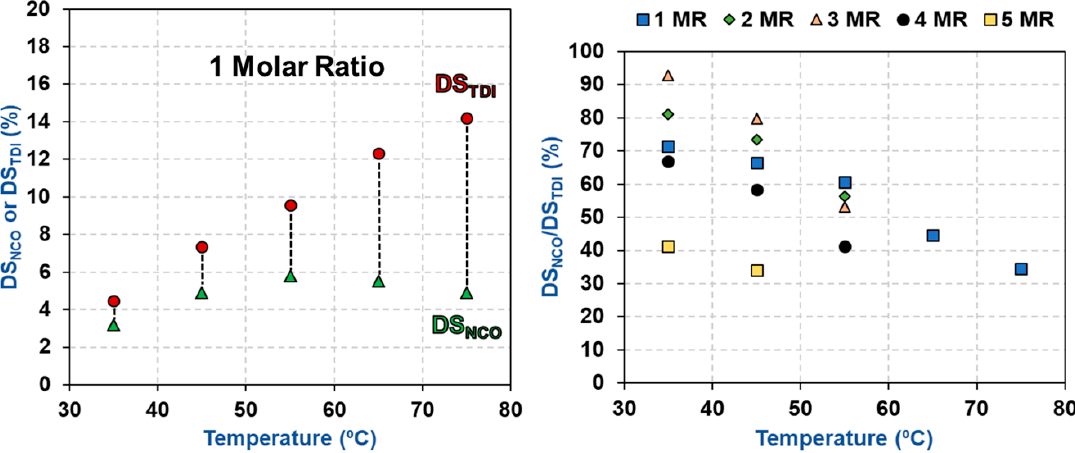
Figure 3. The impact of carbamation temperature on DS NCO , DS TDI , and carbamation efficiency (DS NCO / DS TDI ).